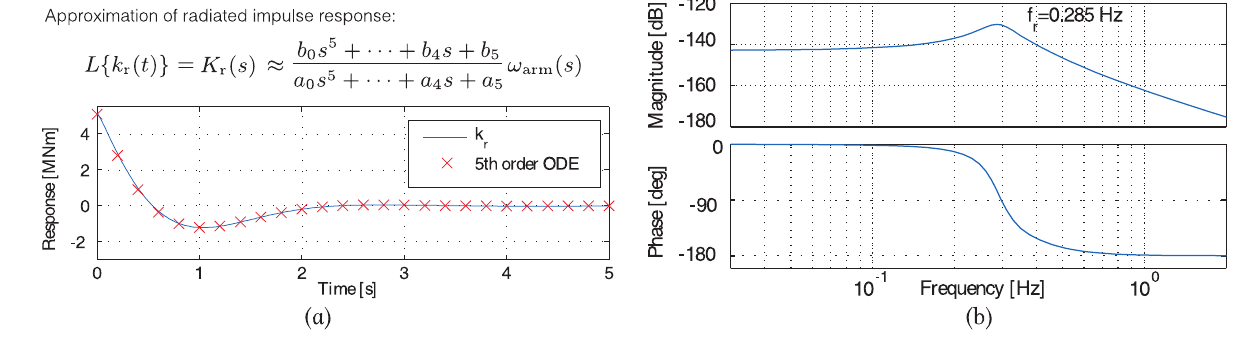
Figure 12. ( a ) the impulse response function, k diagram of Equation (12), θ